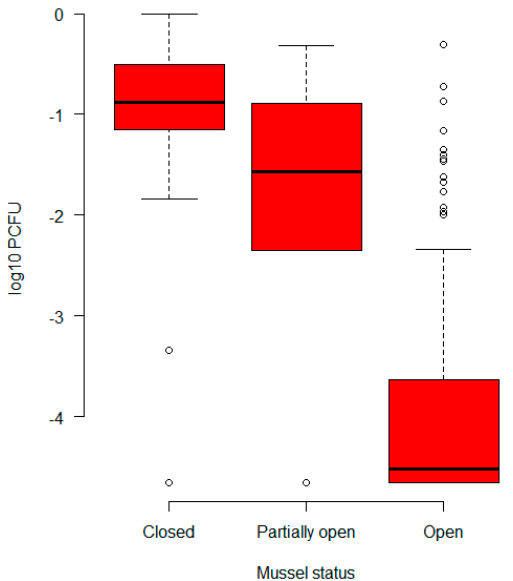
Figure 2. The effect of steam-exposed shell openness status on bacterial concentrations (cfu/g) relative to raw (unopened) mussels (see Equation (2)).